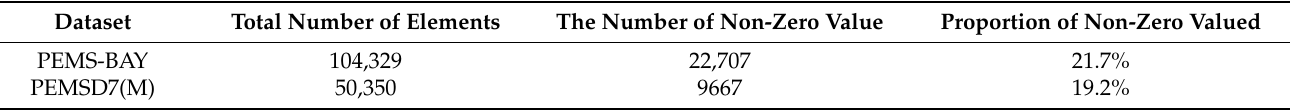
Table 4. Graph wavelet matrix sparsity statistics.